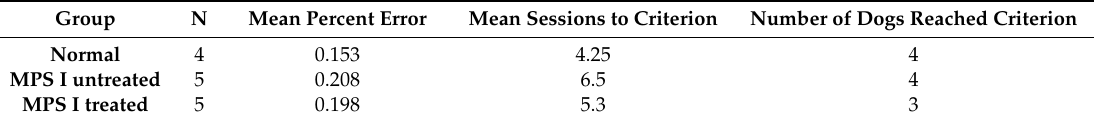
Table 11. Two object visual discrimination descriptive statistics for each group. This includes the number of dogs tested (N) from each group, mean (real) percent error of each group, mean (real) number of sessions performed by each group, and number of dogs from each group that reached the criterion in the allotted 80 trial maximum.